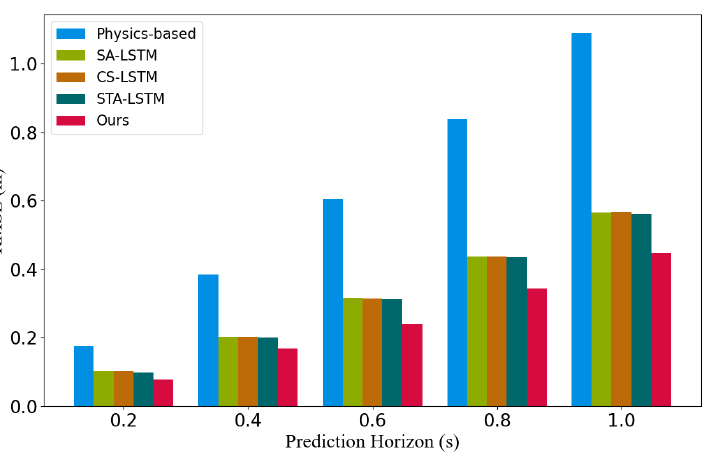
Figure 6. Compare the RMSE of our method with the physics-based method, SA-LSTM [43], CS- LSTM [15], and STA-LSTM [44] within five time